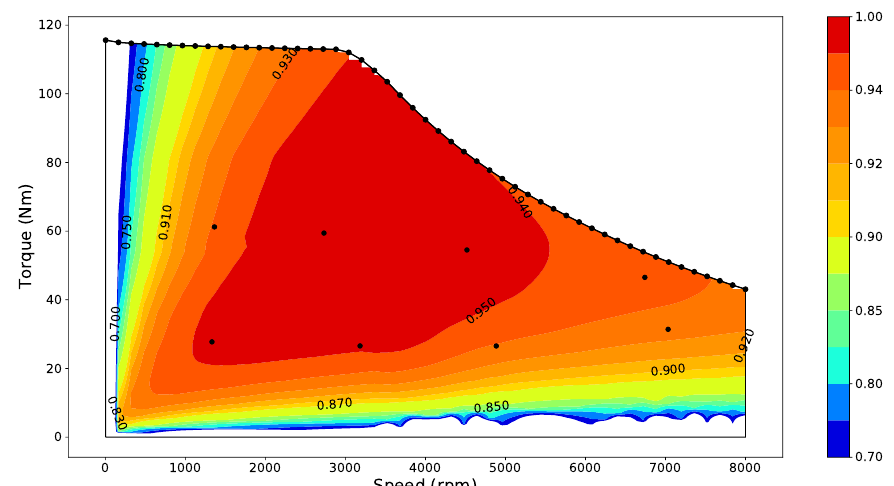
Figure 15. Efficiency map of eight ECG points with multi-point method.